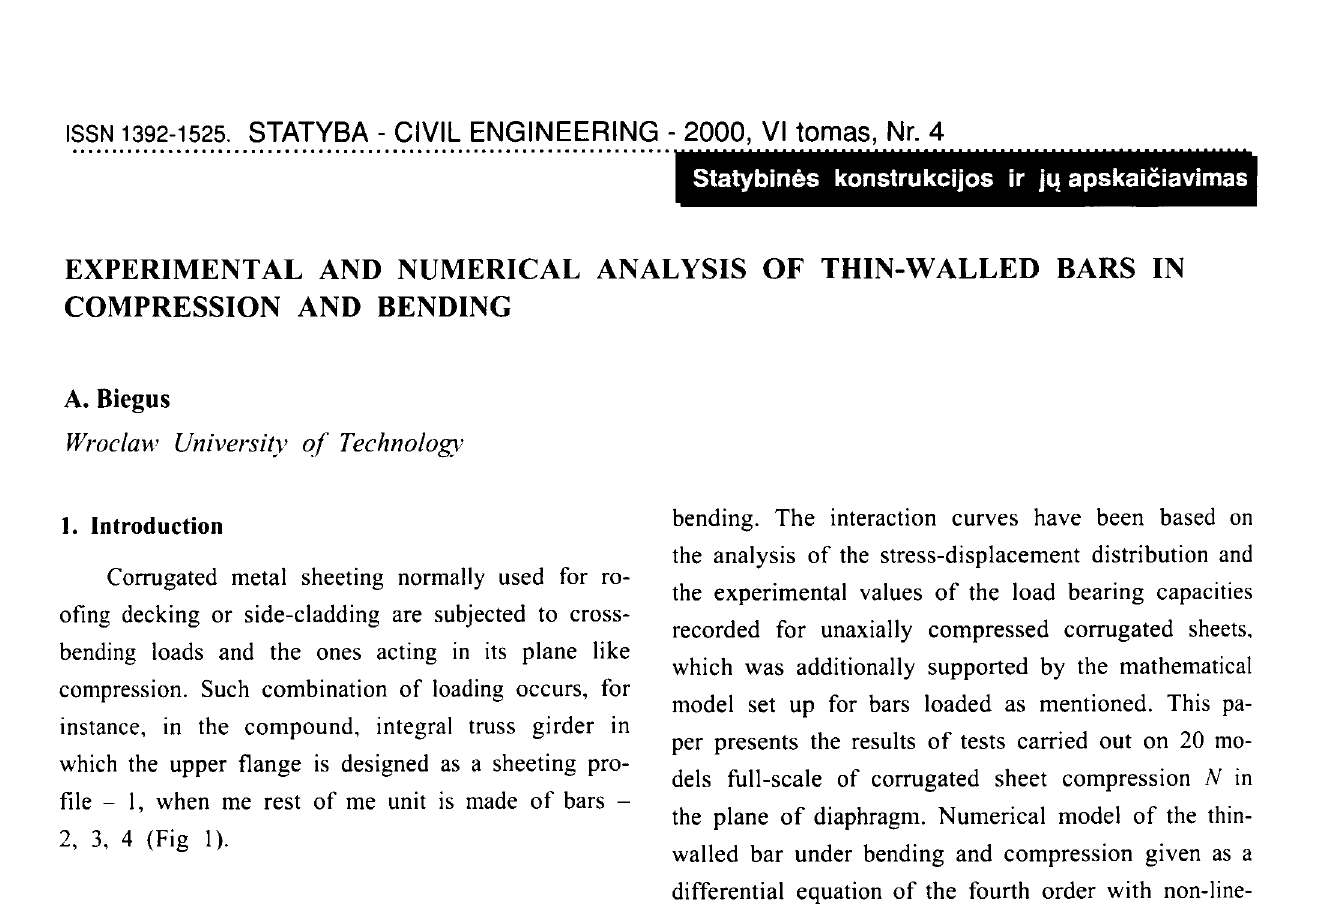
Fig I. Scheme of the plate-girders Theoretical investigations of Easley [I], Hlavacek [2] and experiments executed by Bryan [3], [4] Da vies [5] and Easley [!], [6] have considered the pure in plane shearing without the participation of trans versal and compression forces. The main attention was paid to the flexibility of sheeting profile under shea ring. For the sheeting profile sufficiently fixed to the rest of the structure the exhaustion of the load capa city can be caused by the interaction of bending and compression (for slender elements) or by combined ben ding and